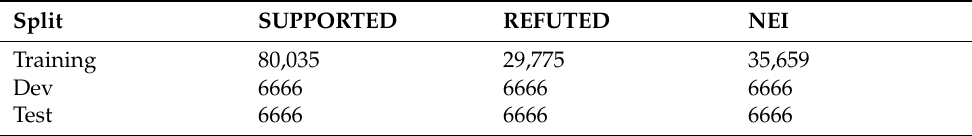
Table 2. Statistics of